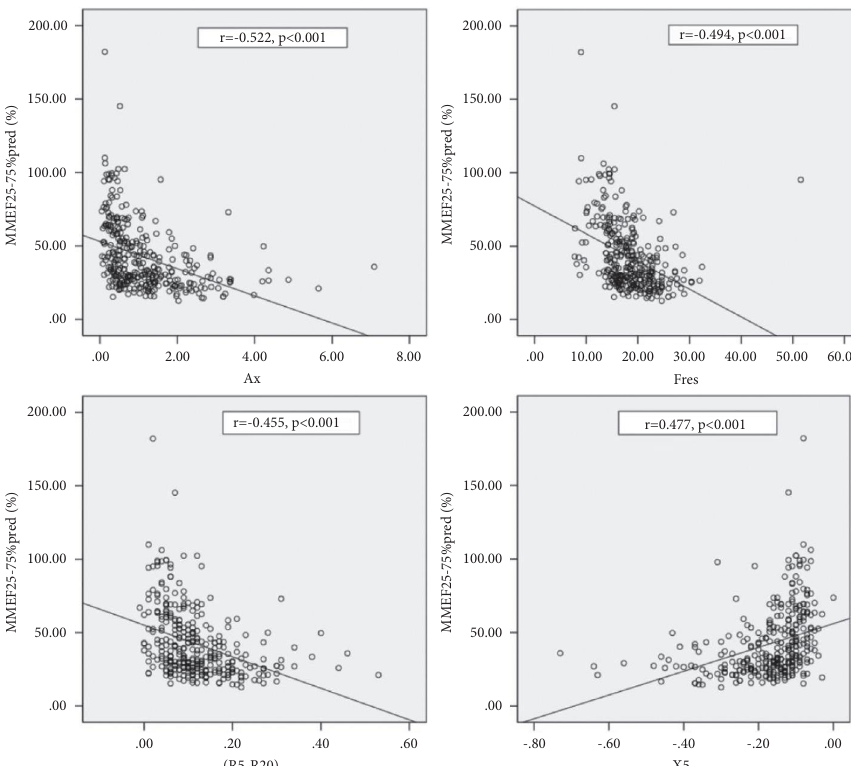
Figure 3: Relationship between MMEF 25–75% pred and IOS parameters. Statistical analyses are performed with Spearman correlation to compare correlation between MMEF 25–75% pred and IOS parameters. Significant negative correlations were observed in MMEF 25–75% pred and Ax ( r �− 0.522), Fres ( r � − 0.494), and R 5– R 20 ( r � − 0.455); p < 0 . 001. By contrast, moderate positively related to MMEF 25–75% pred and X 5 ( r � 0.477); p < 0 .